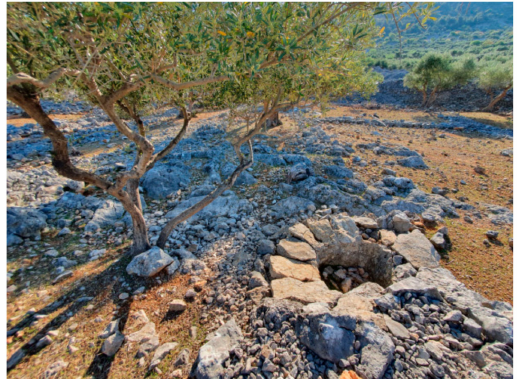
Figure 5. Vaške (from Italian: vasche ) as land use indicators, normally where the vines were present Constructed by the use of both concrete and dry stones (Tanja Kremeni´c,